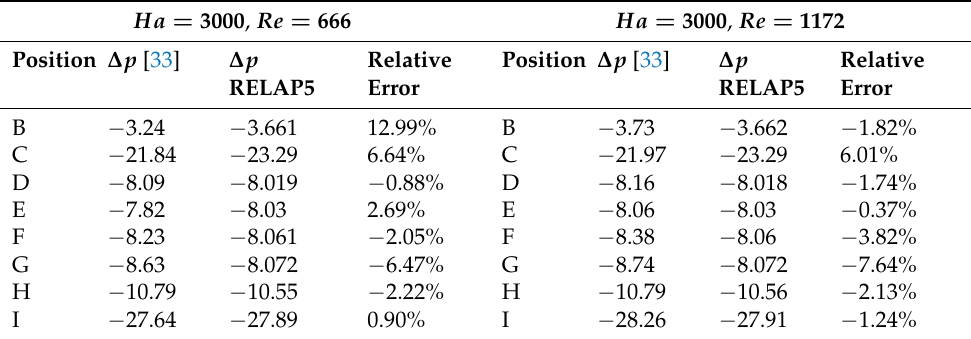
Table 13. Pressure drop results (nondimensional) for every position of flow path and total loss. Relative Errors are